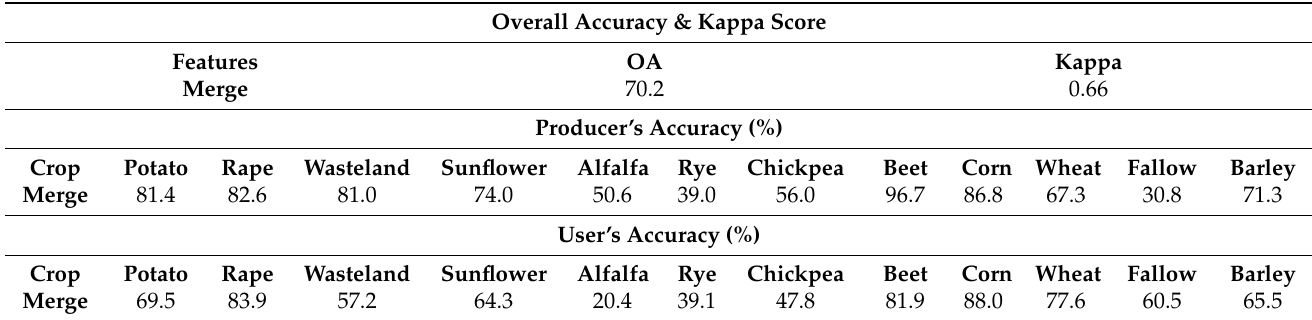
Table 6. Classification scores with eight Sentinel-1 images and eight PAZ